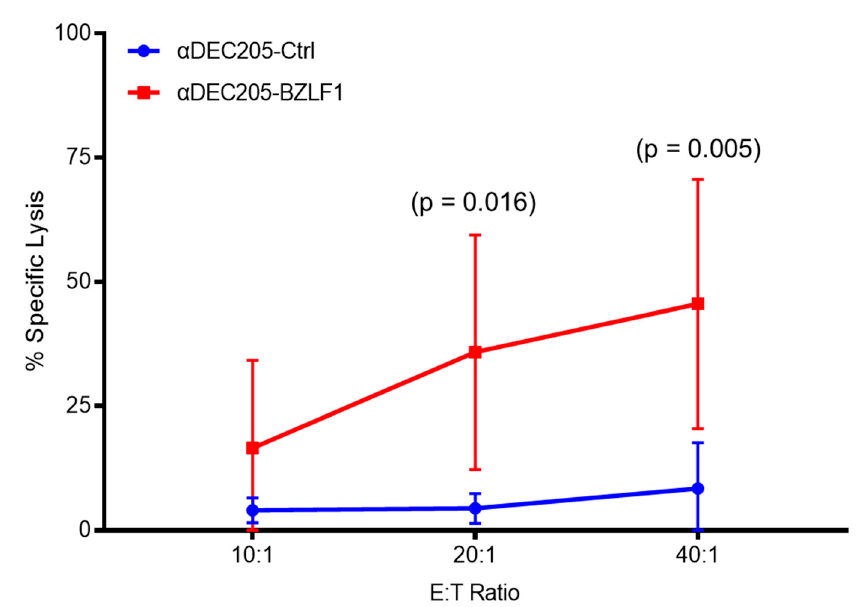
Figure 4. Percentage of killing on flow cytometry-based cytotoxicity assay at three E:T ratios.